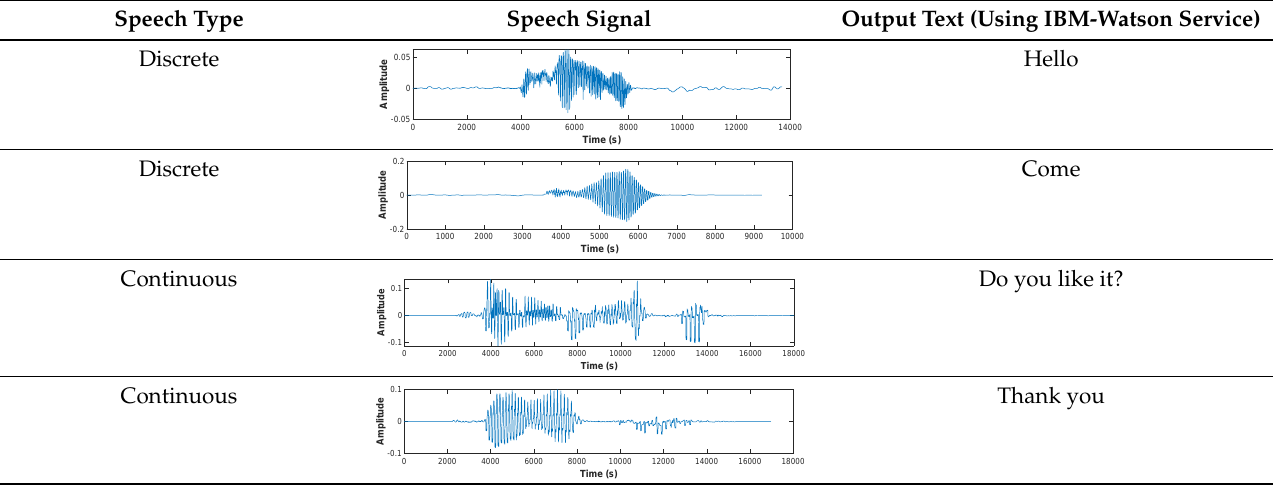
Table 6. Mapping of the speech signal to text for different types of speech. Speech Type